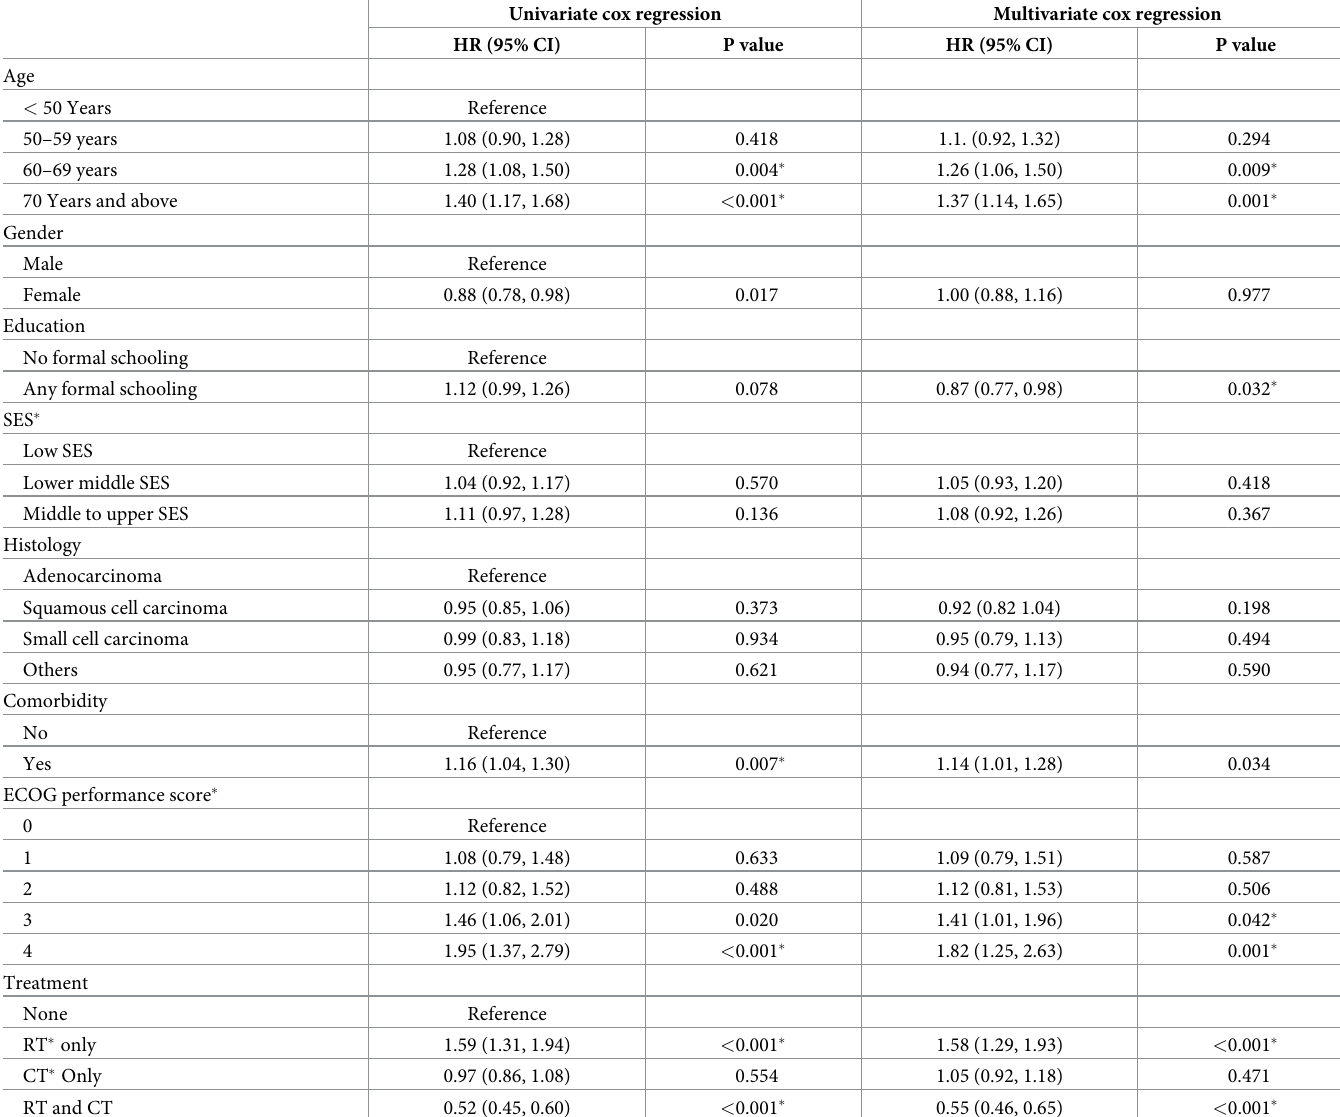
Table 2. Univariate and multivariable Cox-proportional hazards models for survival following among lung cancer patients attend at NICRH for